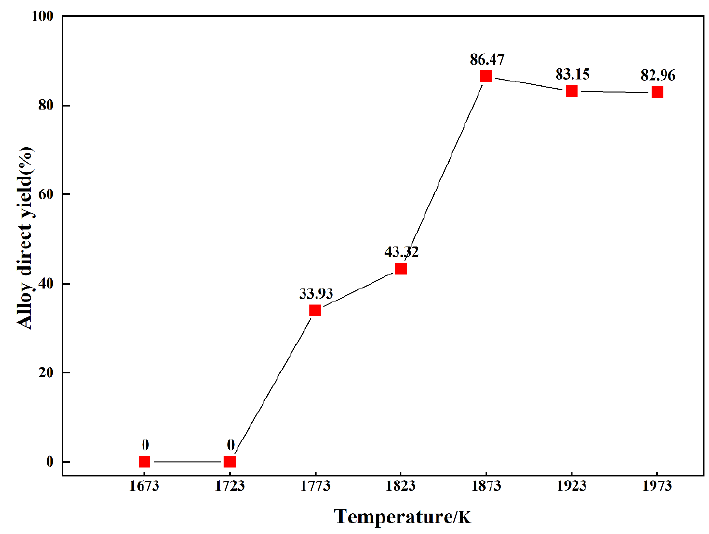
Figure 7. Direct yields of alloys at varying reduction temperatures.